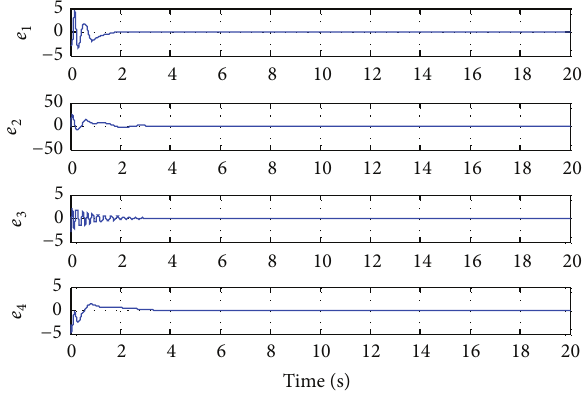
Figure 4: Time histories of estimated parameters for Case